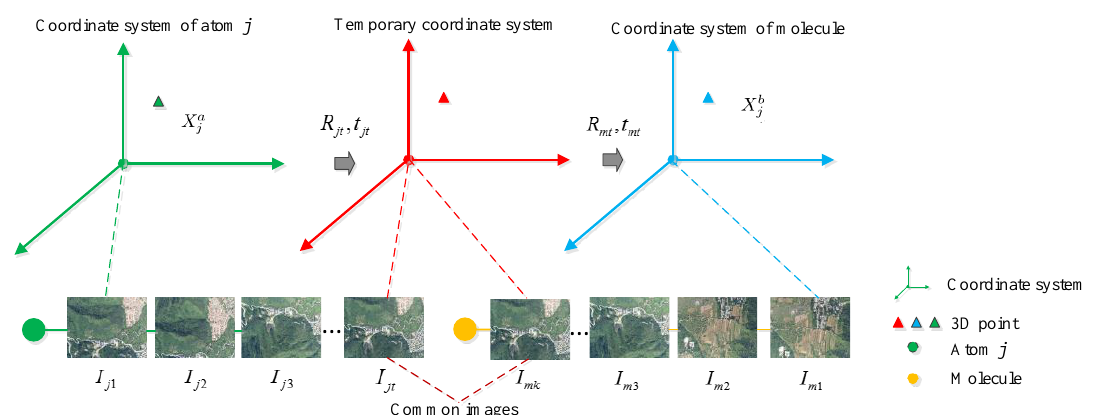
Figure 3. An illustration of the similarity transformation initial estimation. The estimation of the similarity transformation contains two stages. In the first stage, a transformation can be realized from the frame of the atom to the temporary frame by means of the camera pose corresponding to the common images in the frame of the atom. In the second stage, a transformation from the temporary frame to the frame of molecule can further be realized by means of the camera pose corresponding to the common images in the frame of the